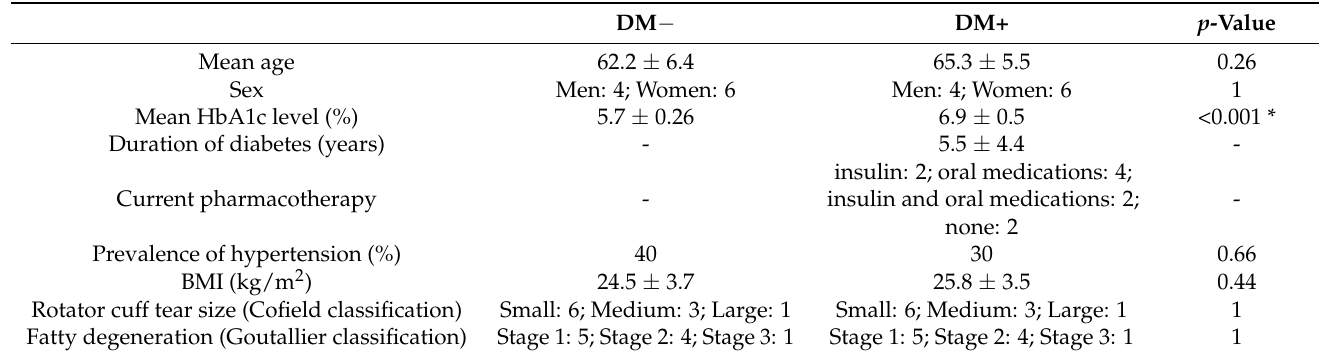
Table 2. Patient background characteristics.